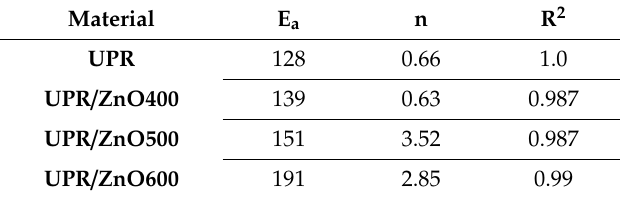
Table 4 kinetic parameters obtained from the Kissinger model fitted to the TGA experiments. Table 4. Degradation kinetic parameters obtained from the Kissinger